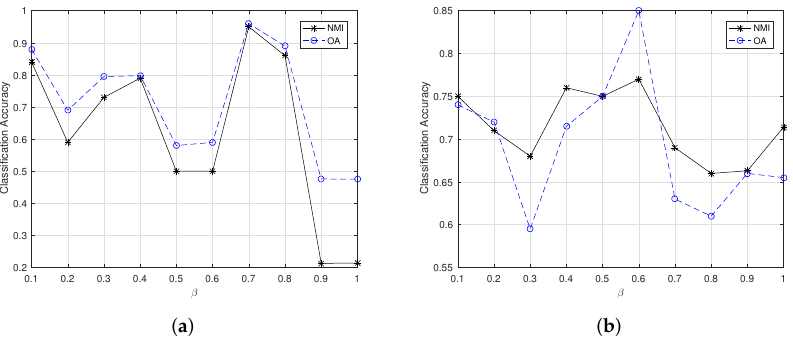
Figure 4. The change of clustering OA and NMI for large-scale HSIs yielded by CSSCAG with different β . ( a ) The Salinas dataset, ( b ) The University of Pavia dataset.